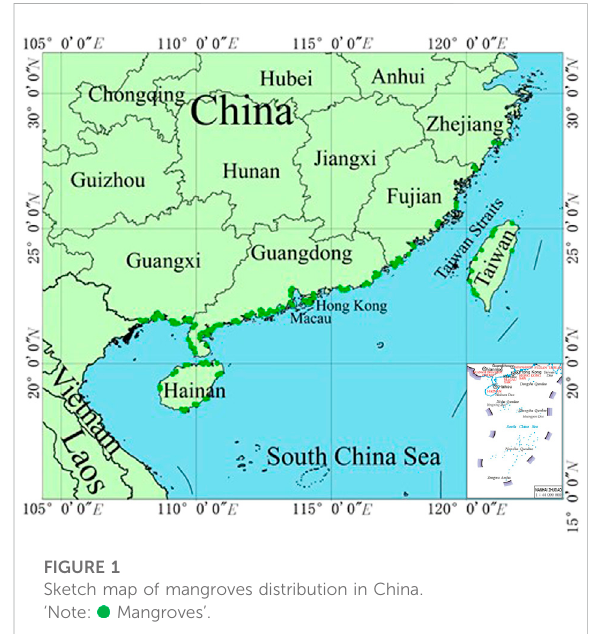
FIGURE 1 Sketch map of mangroves distribution in China. ‘ Note: Mangroves ’